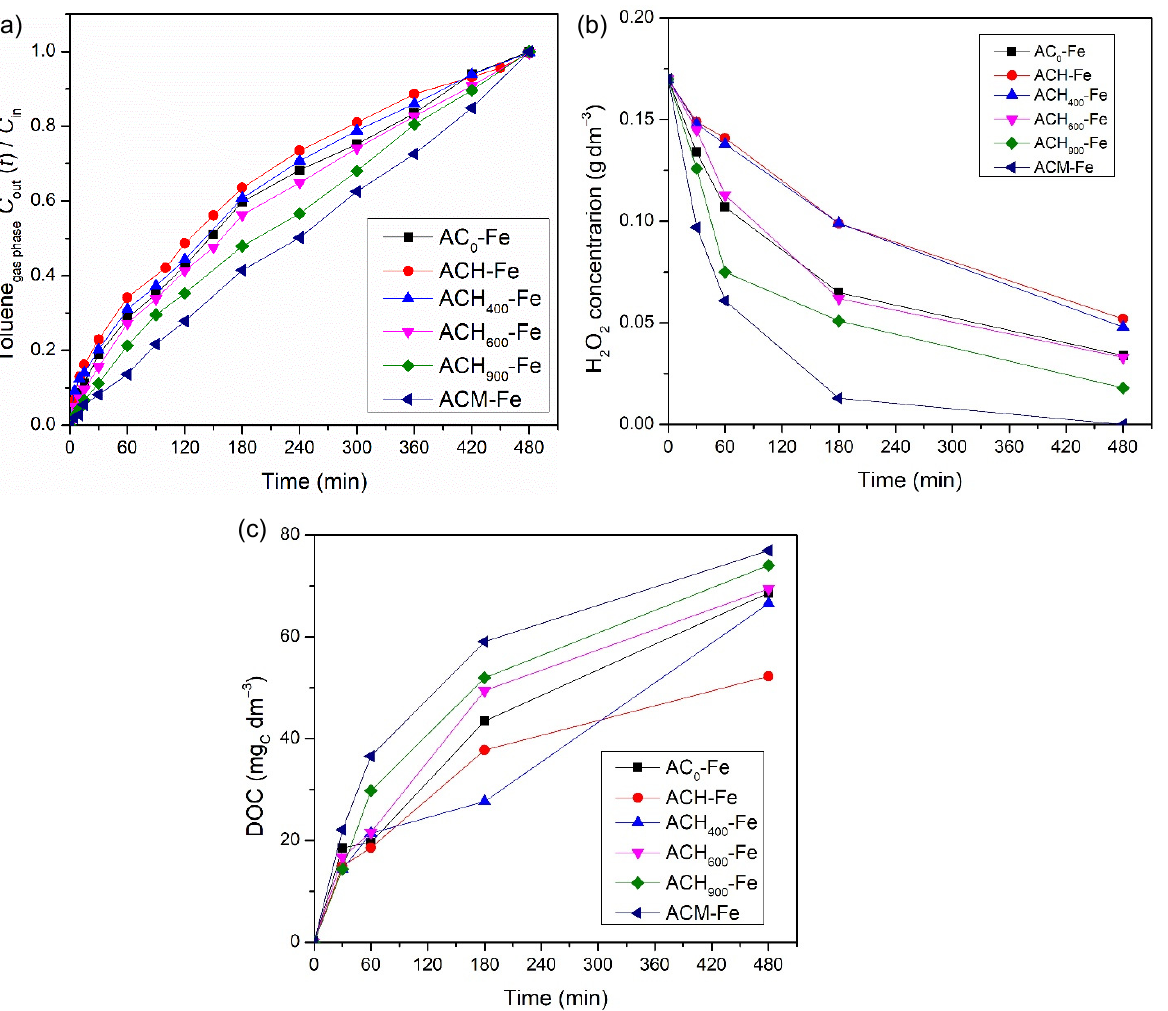
Figure 6. Influence of iron-based catalysts on the toluene concentration at the outlet of the bubble reactor ( a ), on the concentration of H 2 O 2 ( b ), and on the DOC concentration ( c ) in the liquid phase during heterogeneous Fenton oxidation experiments. Experimental conditions were as follows: pH 0 = 3.0, [catalyst] = 0.75 g dm − 3 , [H 2 O 2 ] = 0.005 mol dm − 3 , Q air = 0.15 dm 3 min − 1 .